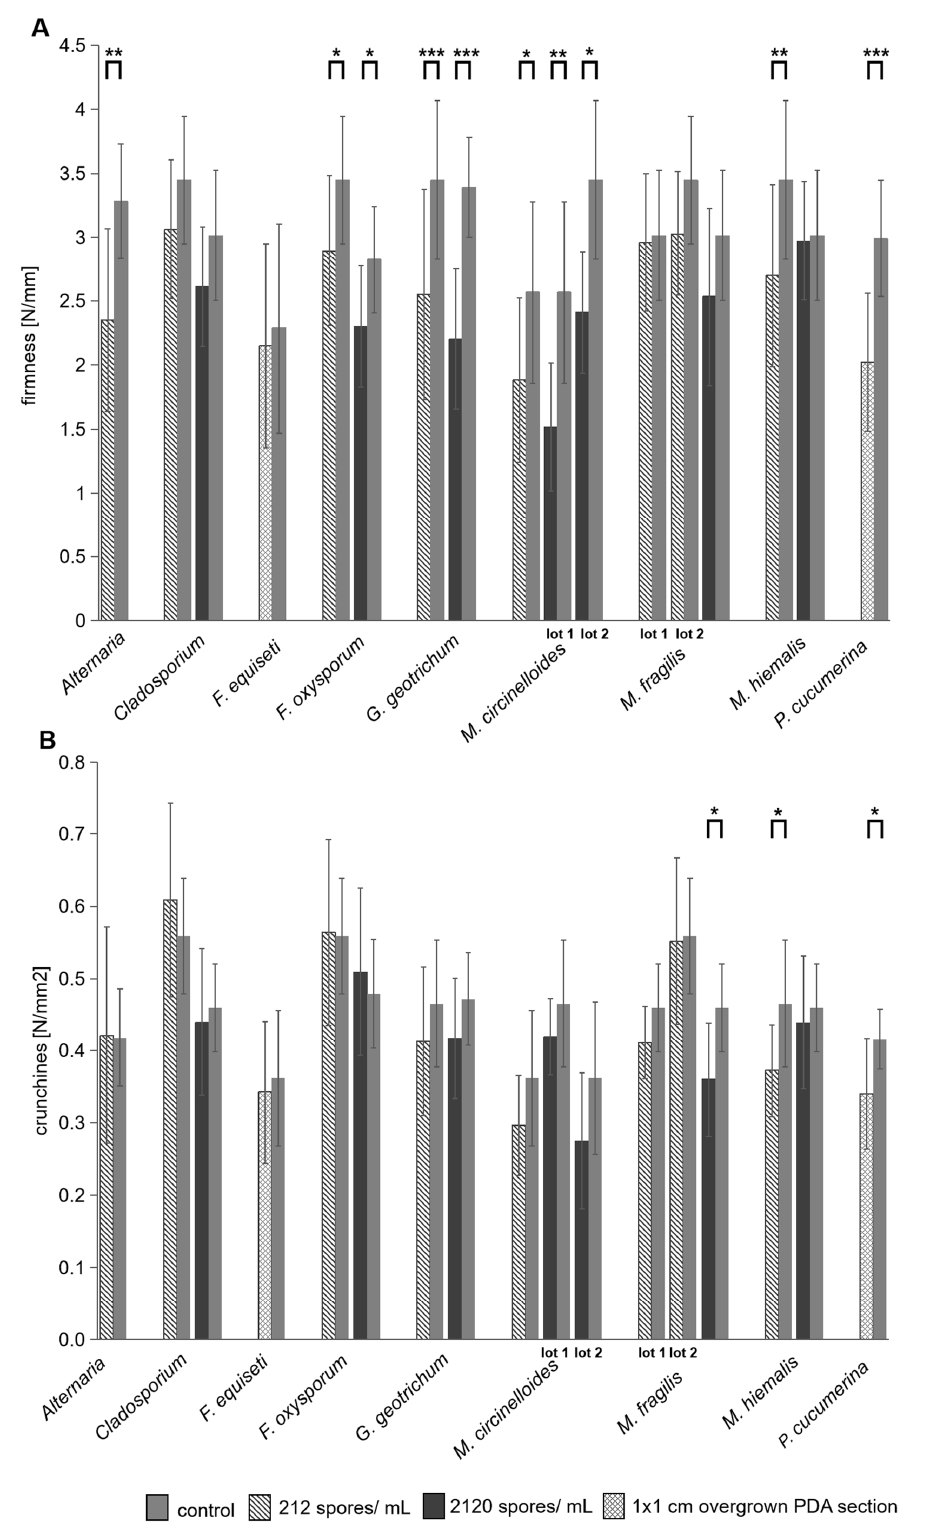
Figure 4. Texture changes in gherkins due to fungal inoculation. Ready-to-sell pickle jars were inocu- lated with spore suspensions of the fungi Plectosphaerella cucumerina , Mucor hiemalis , Mucor fragilis , Mucor circinelloides , Galactomyces geotrichum , Fusarium oxysporum , Fusurium equiseti , Cladosporium sp., and Alternaria sp. Inoculation was performed with the final concentrations of 2000 spores/mL